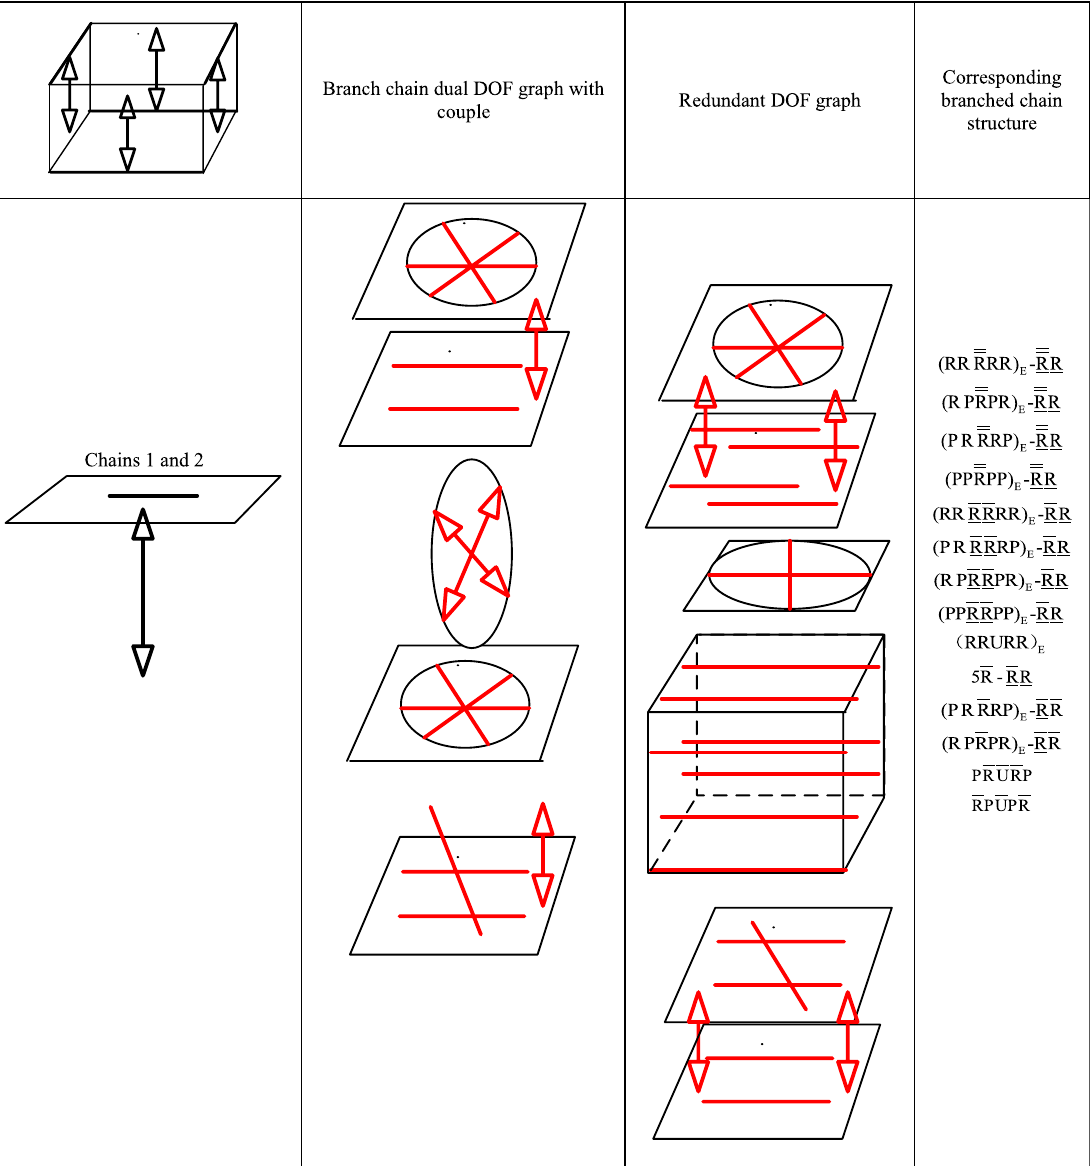
Table 5 Steps (7) ~ (8) synthesis